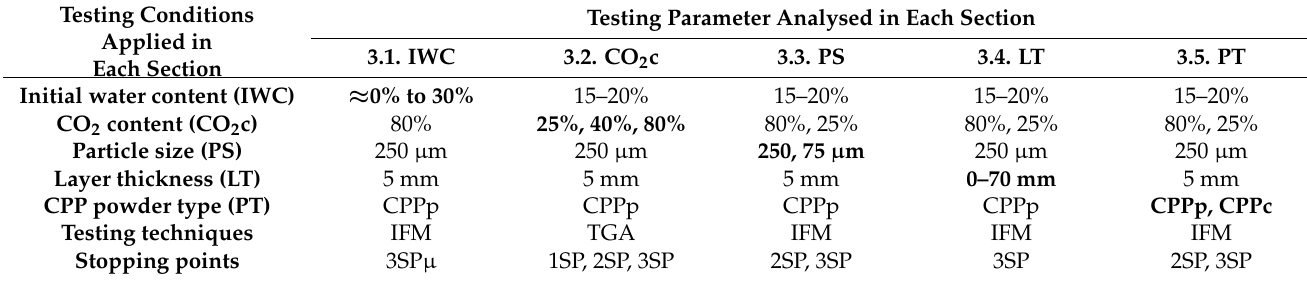
Table 2. Carbonation testing conditions and analytical